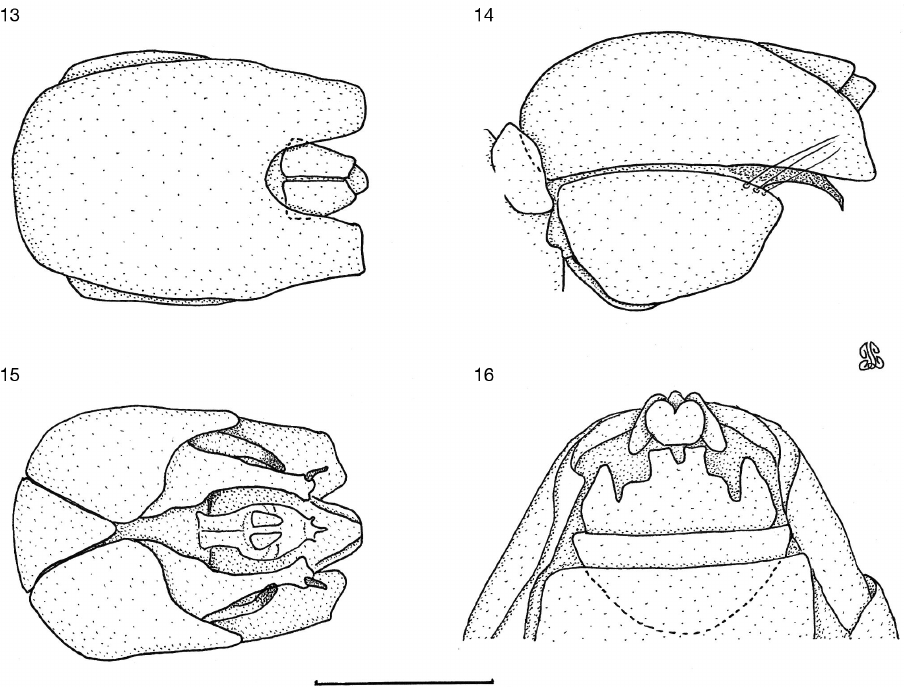
Figures 13–16. Laphyctis argenteofasciata (Ukasi) terminalia: 13 male dorsal 14 same, lateral 15 same ventral 16 female ventral. Scale = 1 mm, setation